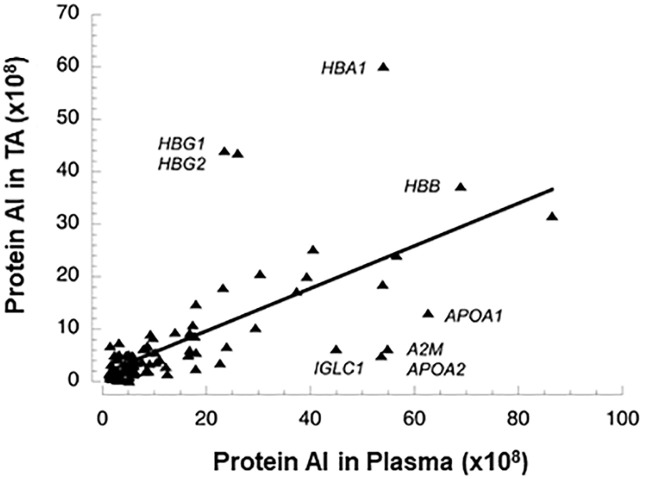
Comparison of abundance levels for proteins present in both TA and plasma of premature infants.By regression analysis r = 0.69 (p<0.00001) excluding albumin as an outlier, which had AI values of 179 and 315 for TA and plasma, respectively. Gene symbols are shown for some outlier proteins.